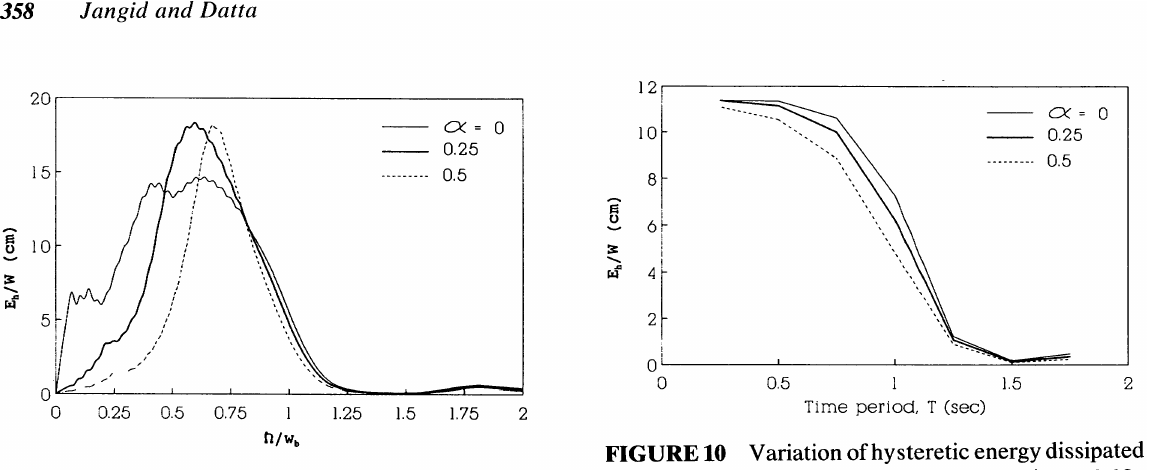
FIGURE 8 Variation hysteretic energy dissipated against harmonic frequency of excitation; T = 1 s, mb1m = 1.5, and Q)W = 0.08.